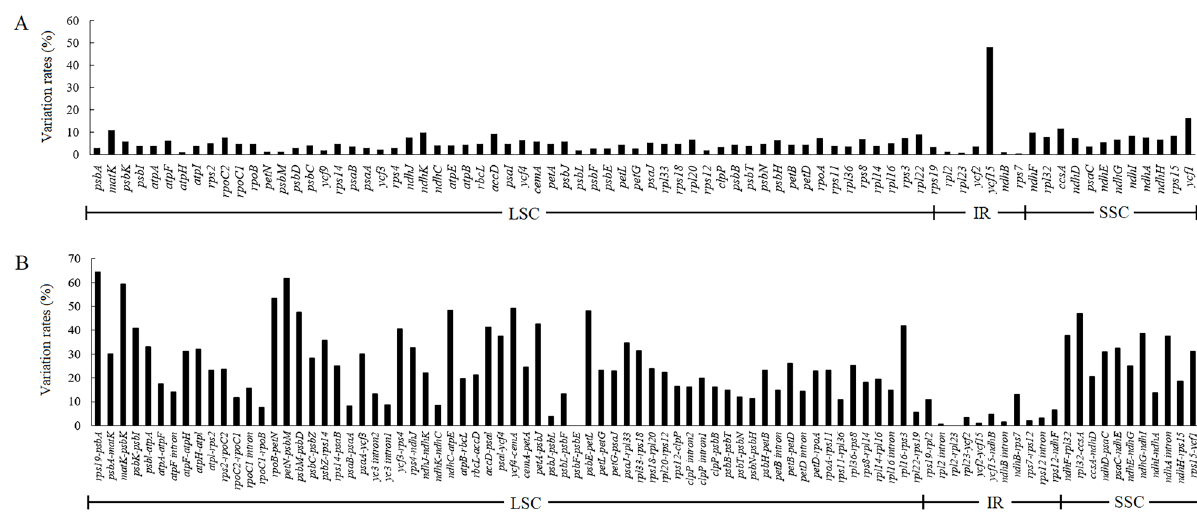
Figure 2 – Variation rates of coding and noncoding regions in the chloroplast genomes of 15 Swertia species. A: Variation rates of 78 protein coding genes; the y-axis represents protein coding genes. B: Variation rates of noncoding regions; the y-axis represents intergenic spacers or introns. Abbreviations: LSC- large single copy region; SSC- small single copy region; IR- inverted repeat region.